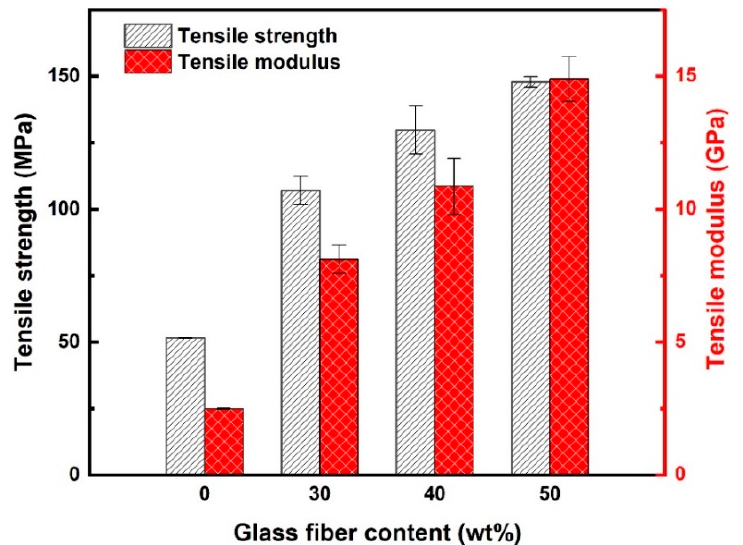
Figure 3. Effect of GF content on tensile strength and modulus of GF/mPPO composites.